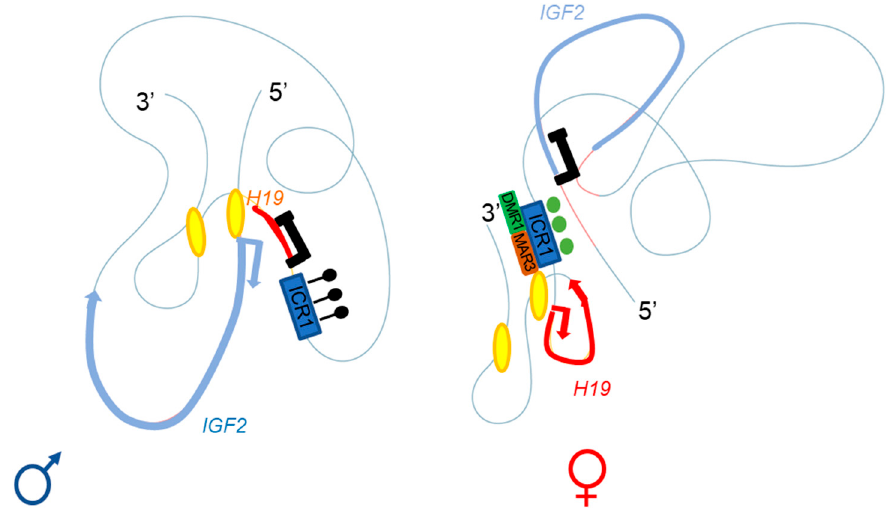
Figure 4. Adapted from Rovina et al. [60]. Three-dimensional representation of the IGF2-H19 locus on the paternal ( left ) and maternal ( right ) chromosomes. The ICR1 of the paternal allele is methylated (black lollipops), with enhancers A and B (yellow ellipses) close to the IGF2 promoter; this conformation allows IGF2 expression and H19 repression. The CTCF of the maternal allele can bind the unmethylated ICR1 (green circles), regulating the interaction with DMR1 (green box) and the matrix attachment region (MAR)3 (brown box); the A and B (yellow ellipses) enhancers are close to the H19 promoter. This conformation allows H19 expression and IGF2 repression.